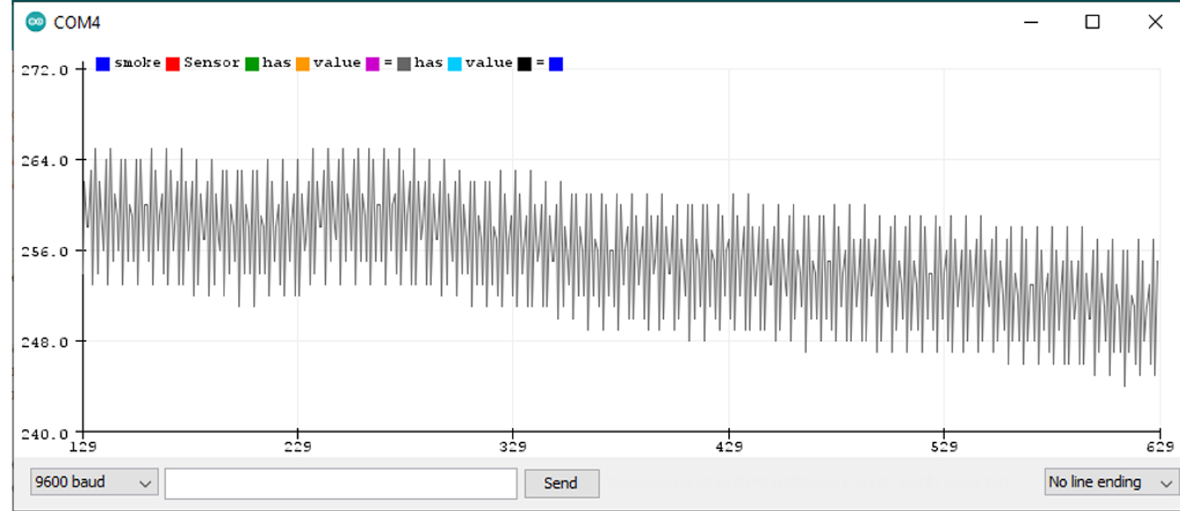
Figure 13. Smoke detector’s waveform when there is